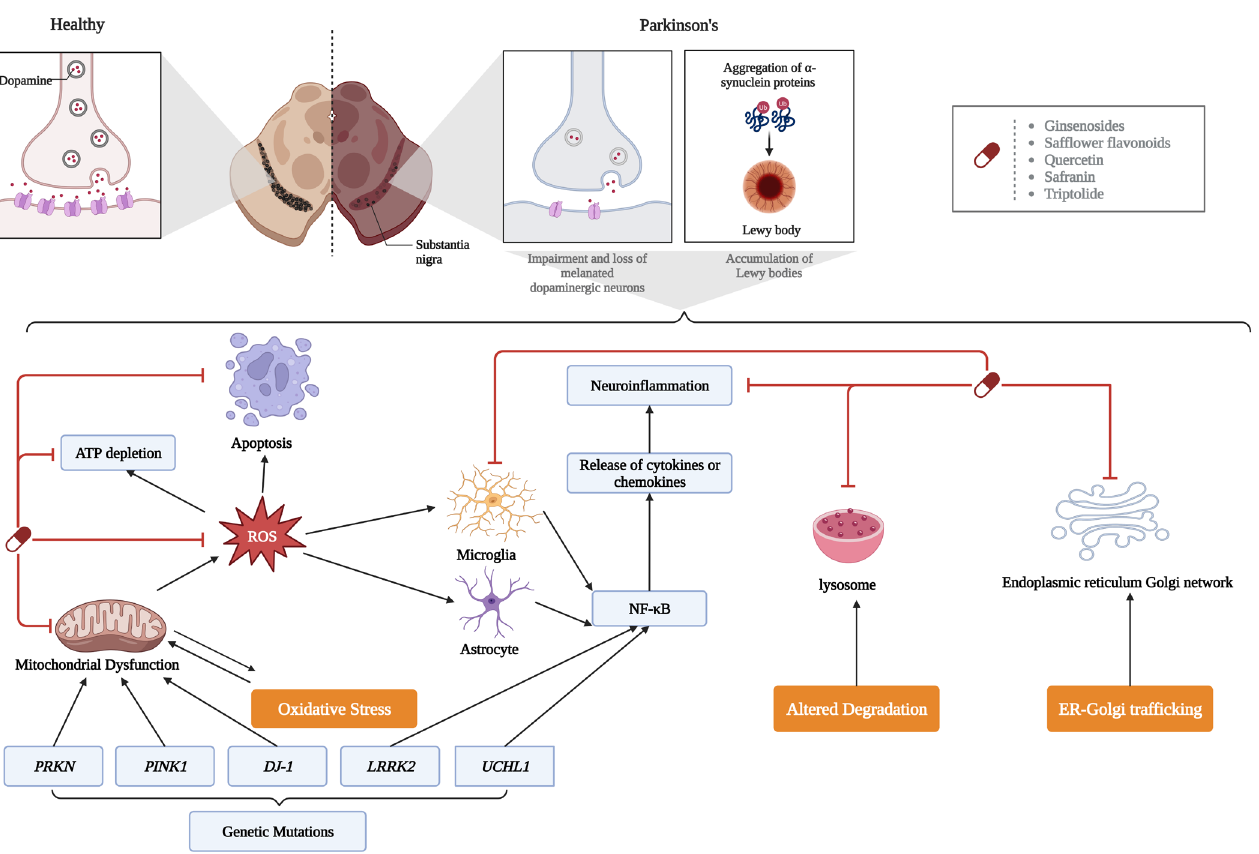
Figure 4. Pathological features of PD and herbal/natural compound strategies. In PD, the aging process leads to the accumulation of intracellular neurotoxic α -synuclein. In turn, the accumulation of α -synuclein exacerbates the aging process. Gene mutations, oxidative stress, endoplasmic reticulum stress, lysosomal degradation imbalance, neuronal dysfunction, and apoptosis play major roles in disease pathogenesis and progression. ATP: adenosine triphosphate; PRKN: parkin RBR E3 ubiquitin protein ligase; PINK1: PTEN-induced putative kinase 1; DJ-1: Parkinson disease protein 7 (PARK7); LRRK2: leucine-rich repeat kinase 2; UCHL1: ubiquitin C-terminal hydrolase L1; NF- κ B: nuclear factor κ